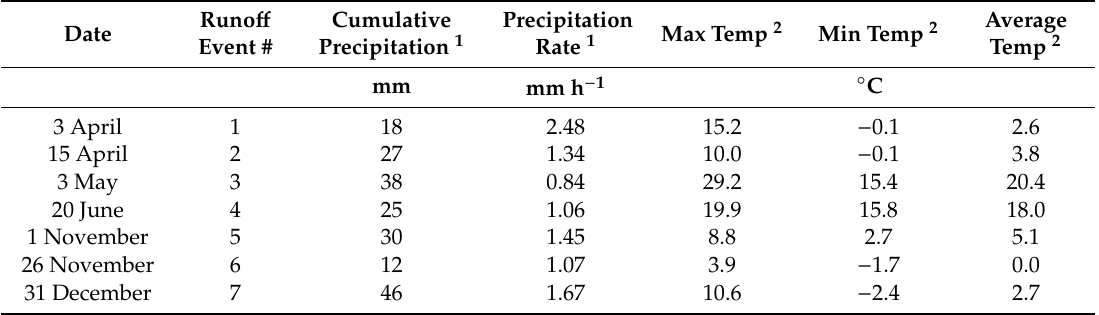
Table 2. Precipitation and temperature for the runo ff events monitored at the blind inlet.